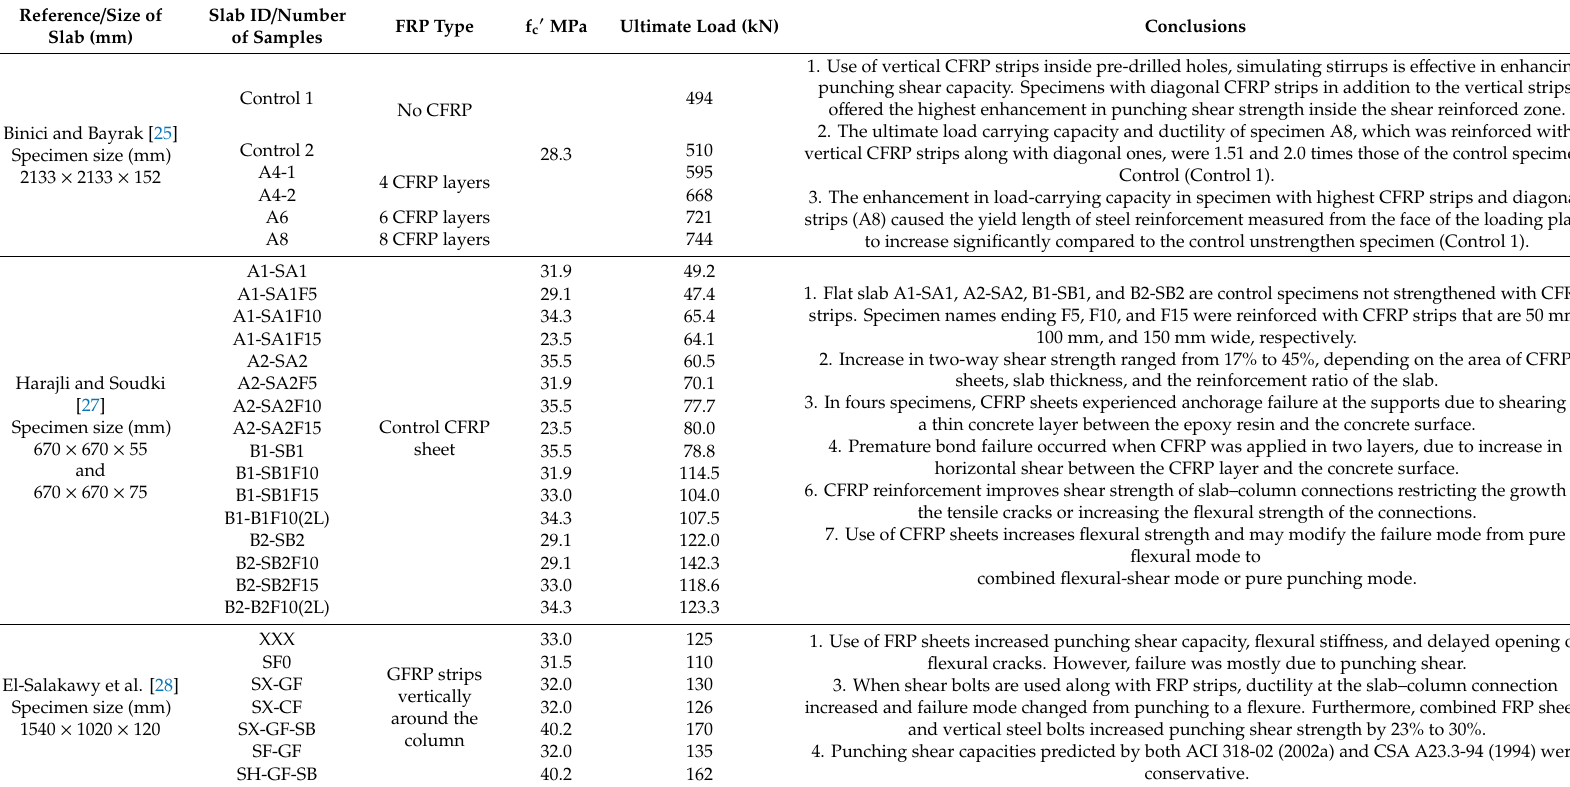
Table 3. Experimental results and numerical simulation of load-carrying capacity of reference reinforced concrete flat